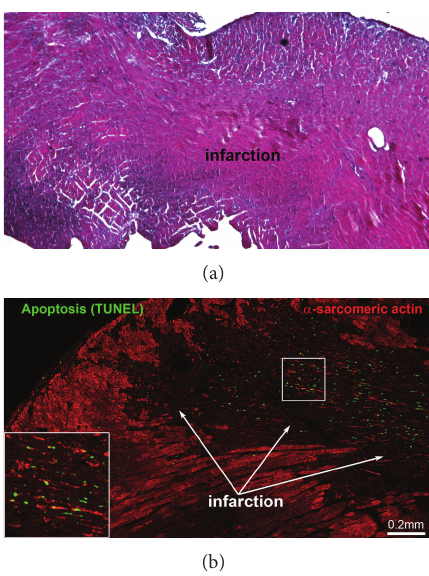
Figure 1: Infarct evaluation. Myocardial infarction 48 hours after coronary artery ligation. Hematoxylin and eosin staining with hypereosinophilic cardiomyocytes and early inflammatory infil- trates (upper panel). Confocal image of the infarcted heart (lower panel) showing apoptosis (TUNEL, green) and the disintegration of structural protein 𝛼 -sarcomeric actin (red) in cardiomyocytes present in the infarcted area. The square represents a high magni- fication of the TUNEL positive